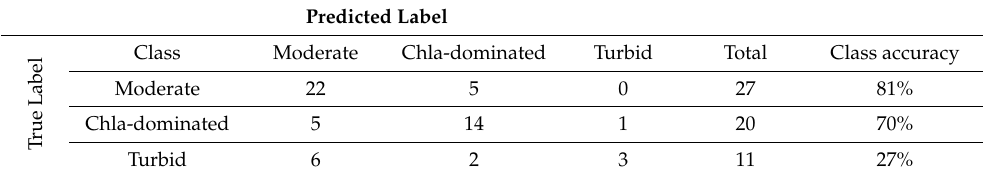
Table 10. Confusion matrix of random forest classification on test (unseen) dataset of 58 observations. Predicted Label